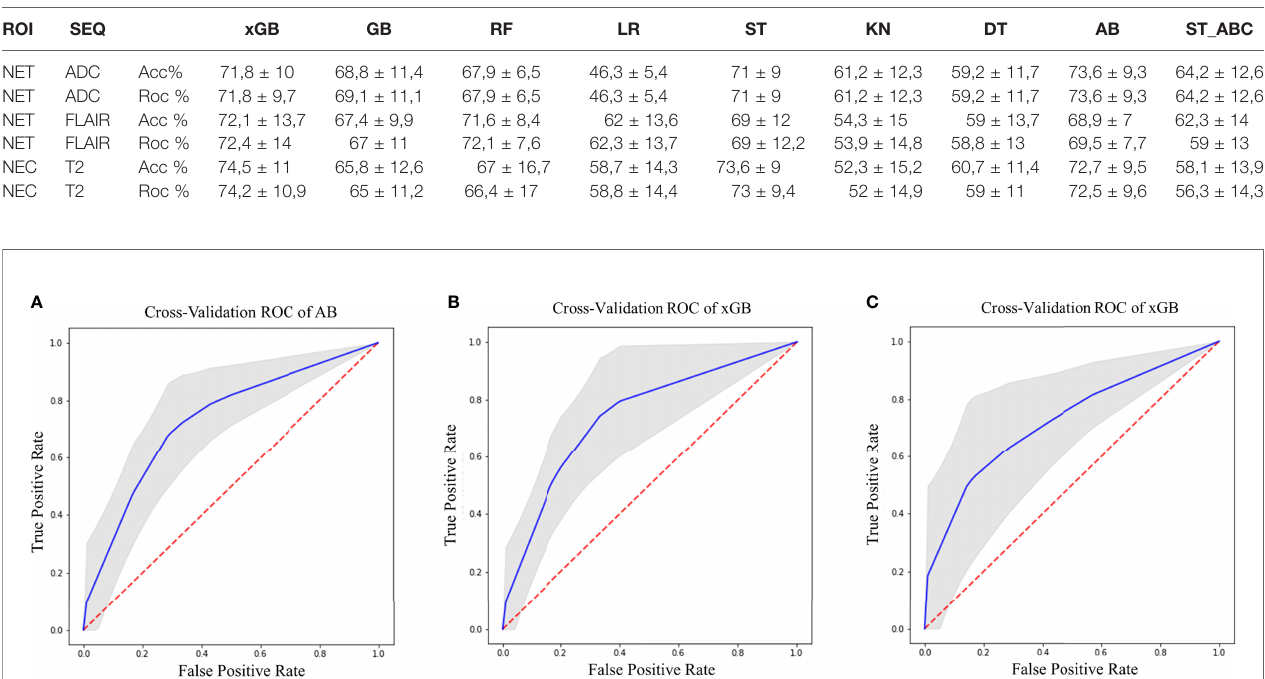
TABLE 2 | Surv12 best results (reported as mean ± standard